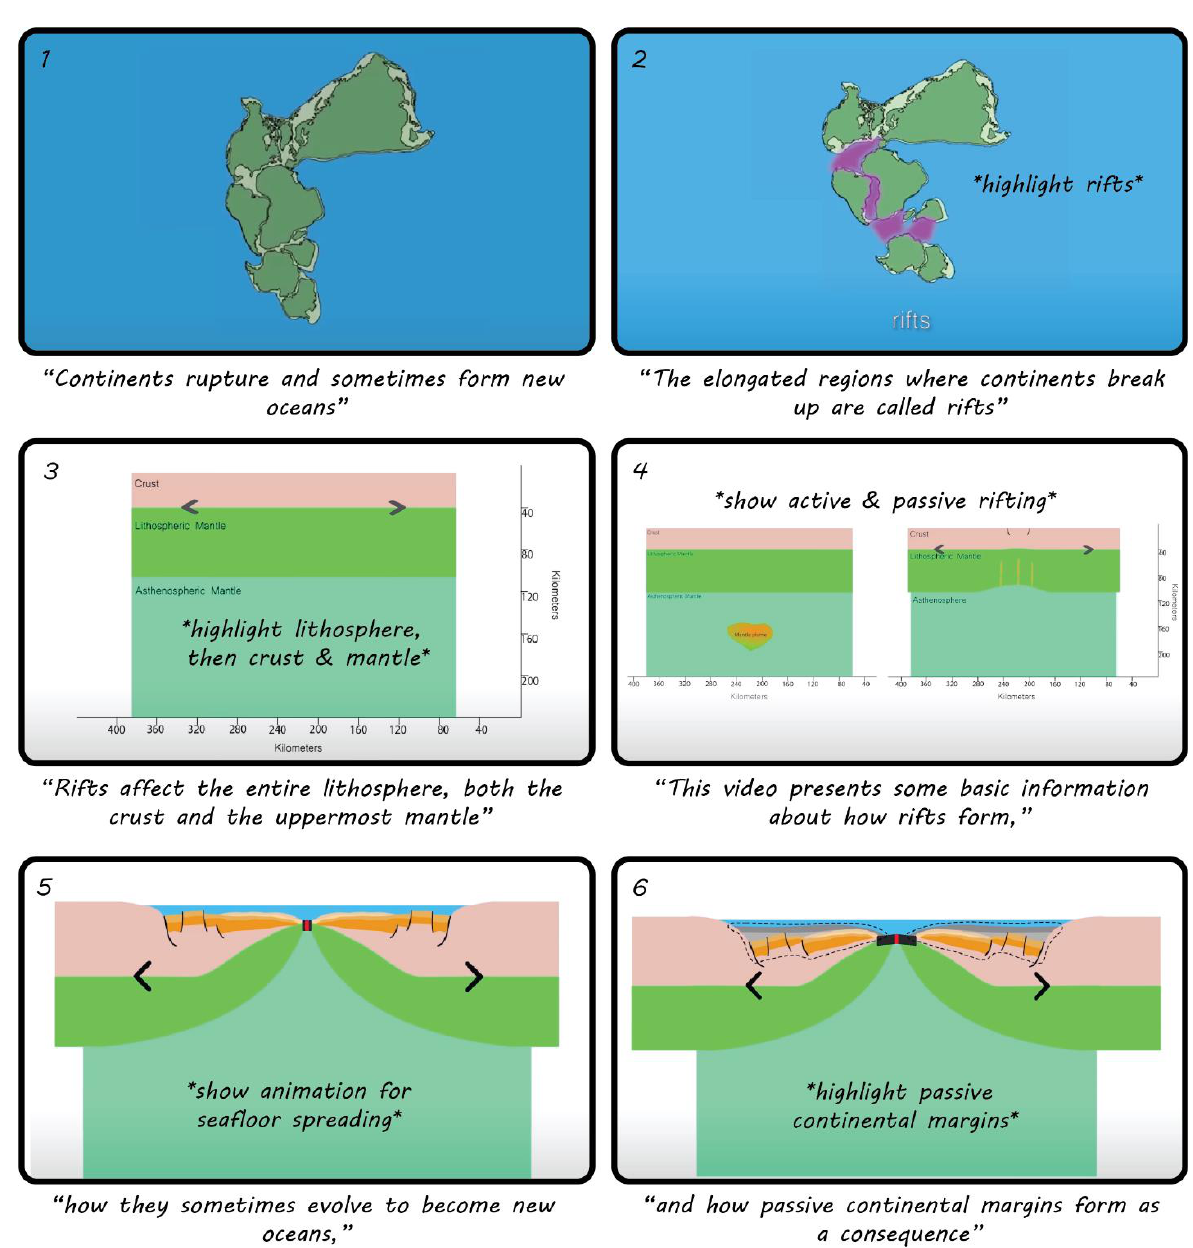
Figure 1. Excerpt of the storyboard for the upper-division rifting video “Continental Rifts, New Oceans, and Passive Continental Margins: Plate Tectonics Basics 2” (see [11]). Depicted are six scenes with portions of the associated narrative underneath. Each scene has a number in the top left corner, an illustration of what is to be animated or a screenshot of a video that will be used, and some notes about what is going to happen during the scene. These may be notes to show specific animations, draw the audience’s attention to something by highlighting it, or adding effects such as speeding up animations.